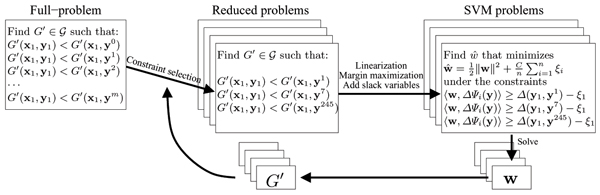
Summary of learning algorithm. In this figure each large frame represents a problem that needs to be solved. On the left, we start with an intractably large problem. At each iteration, we pick a subset of the large problem to work on, solve it approximately using an SVM formulation, and use the resulting solution to expand the subset of constraints we are working with.